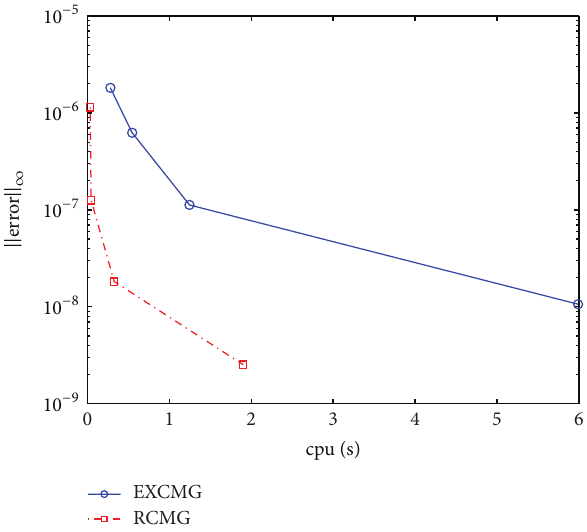
Figure 3: Comparison of the maximum error ‖𝑢 𝐿 − 𝑢‖ ∞ and cpu time for Example 4 with 𝐿 = 3 , taking step lengths ℎ 𝐿 = 1/𝑚 , 𝑚 = 64 , 128 , 256 , and 512 ,